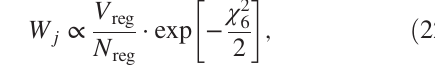
FIG. 3. Comparison of initial distributions of N macroparticles, with the actual χ 2 6 distribution. The sum of the weight of all macroparticles is N ¼ 1 × 10 11 . The bottom right plot displays the same distribution as the plot above, but with a linear